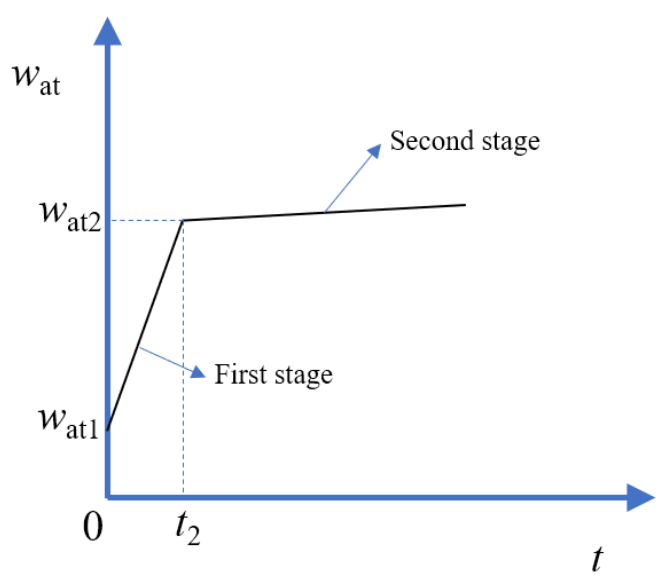
Figure 14. The DWA of the RCA during 24 h.